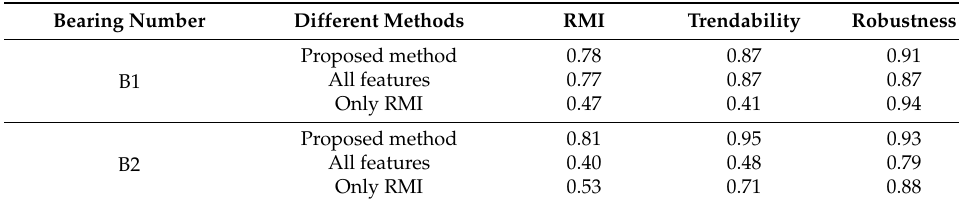
Table 5. Three different metrics of PIs by different methods.